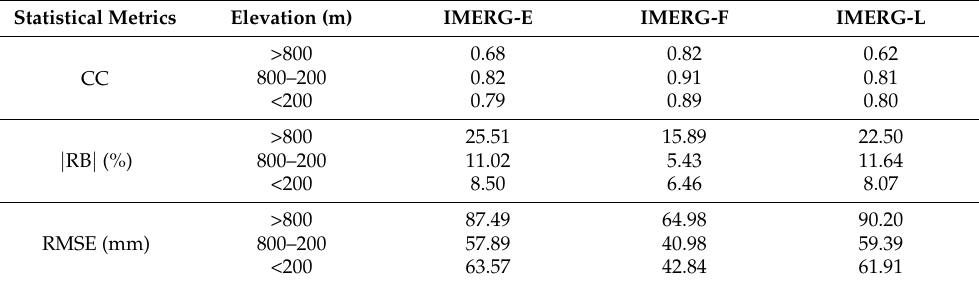
Table 4. Comparison of daily precipitation between IPPs and observed precipitations and a calculation of the average of three statistical indicators related to elevation from 22 June and 4 July in